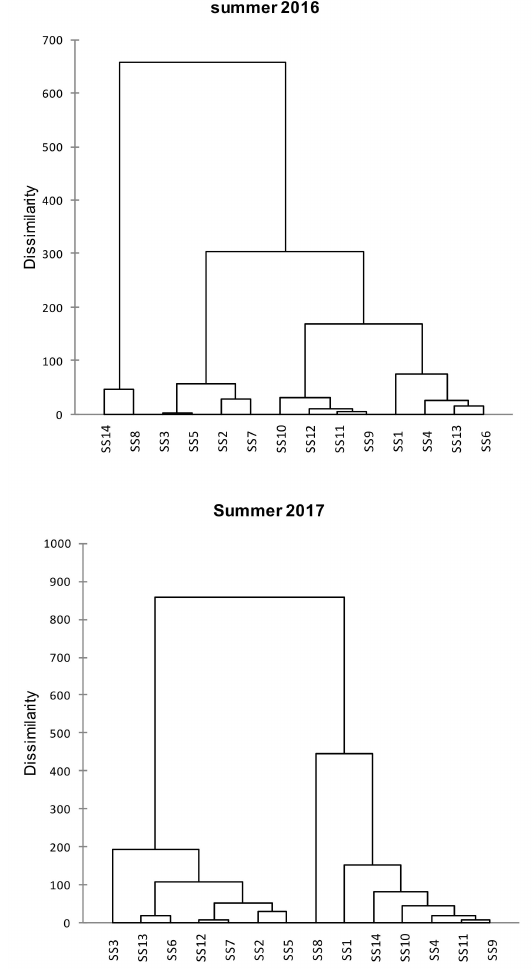
Figure 2. Dendrograms of sampling sites. Table 5. Mean values ( m tot expressed in µ g/m 3 ) of pollutants concentrations measured in SS3 sampling site and the corresponding percentage variation ( ∆ m%) calculated with respect to mean values in Hot Days submatrices ( M HD ) y and to mean values in Heat Waves submatrices ( M HW ) y SS 3 ( N , number of sampling days). N m tot (PM 10